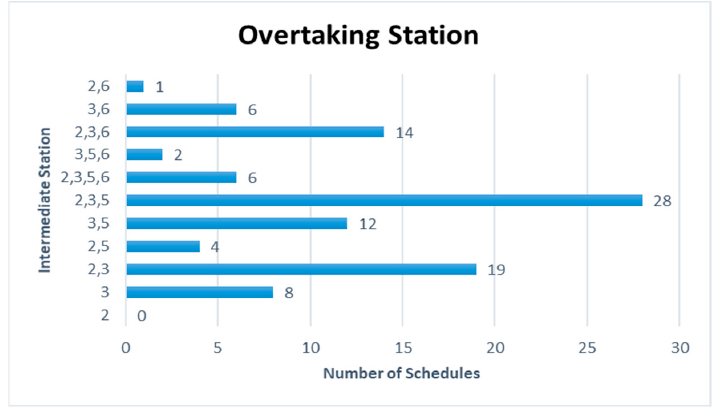
Figure 18. Overtaking Station for Case 4.